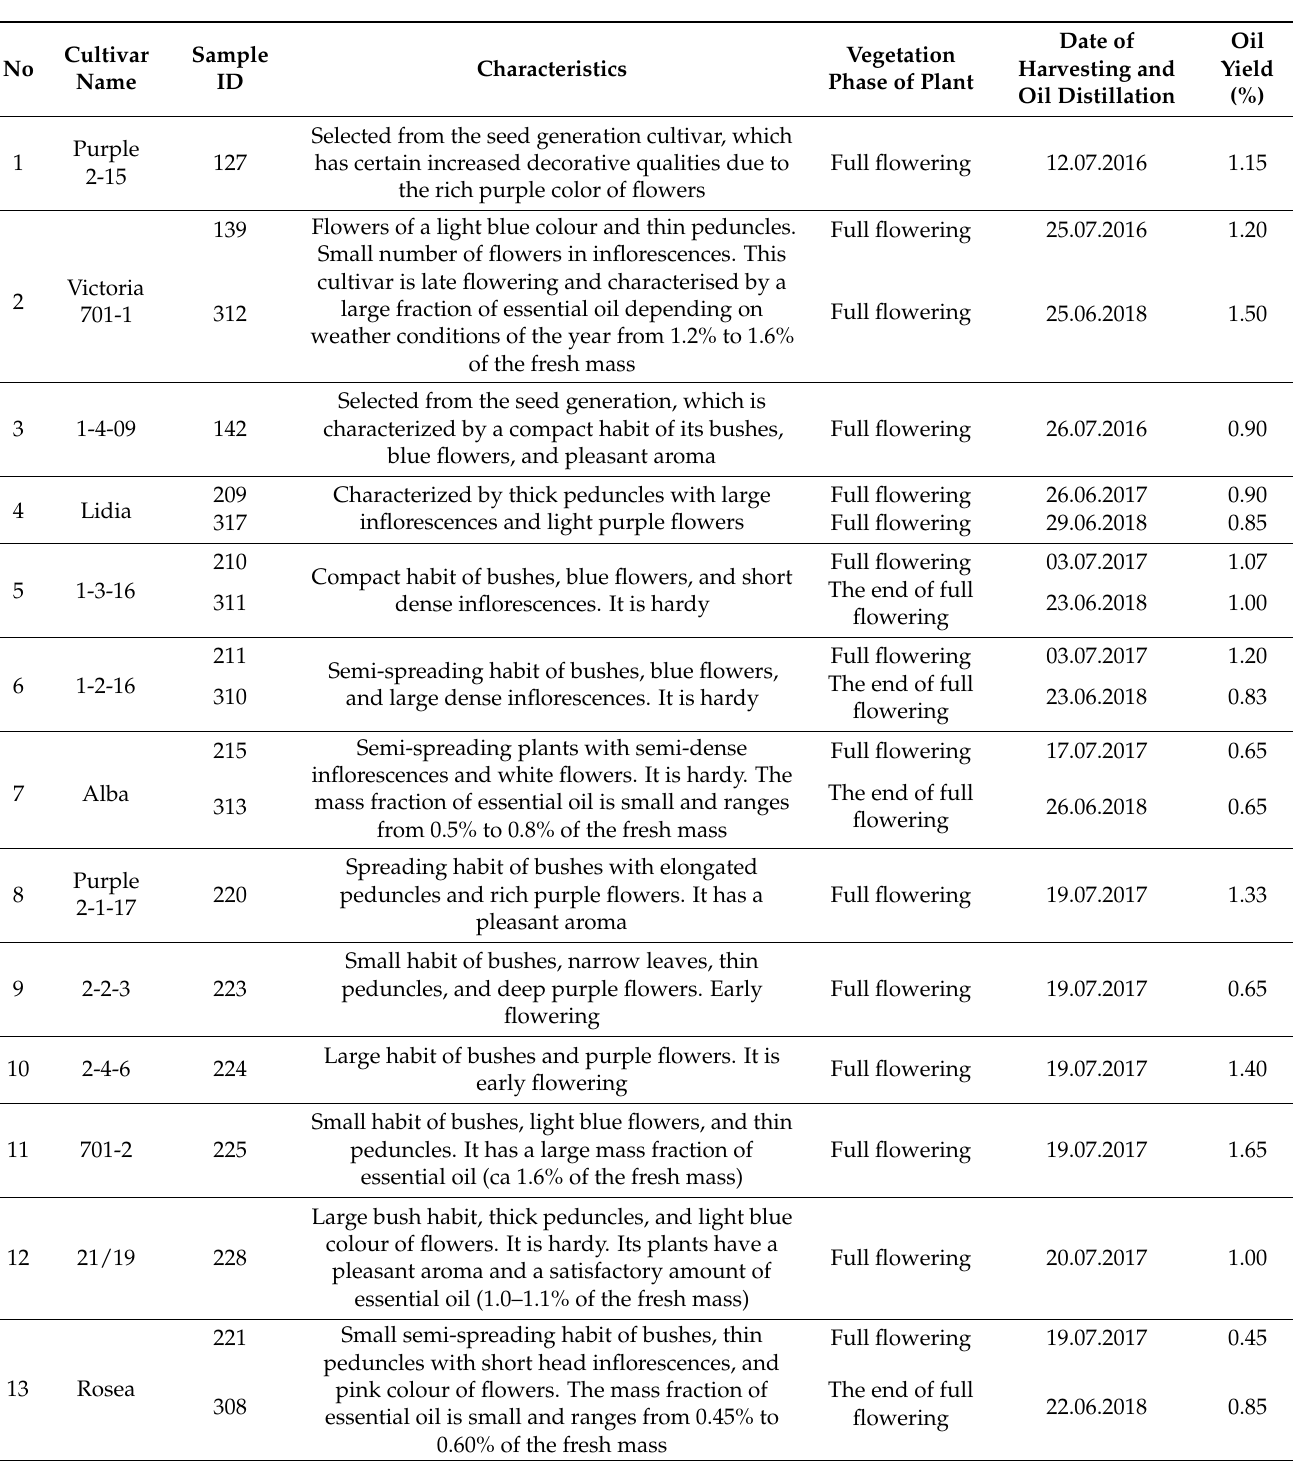
Table 8. Information about the tested